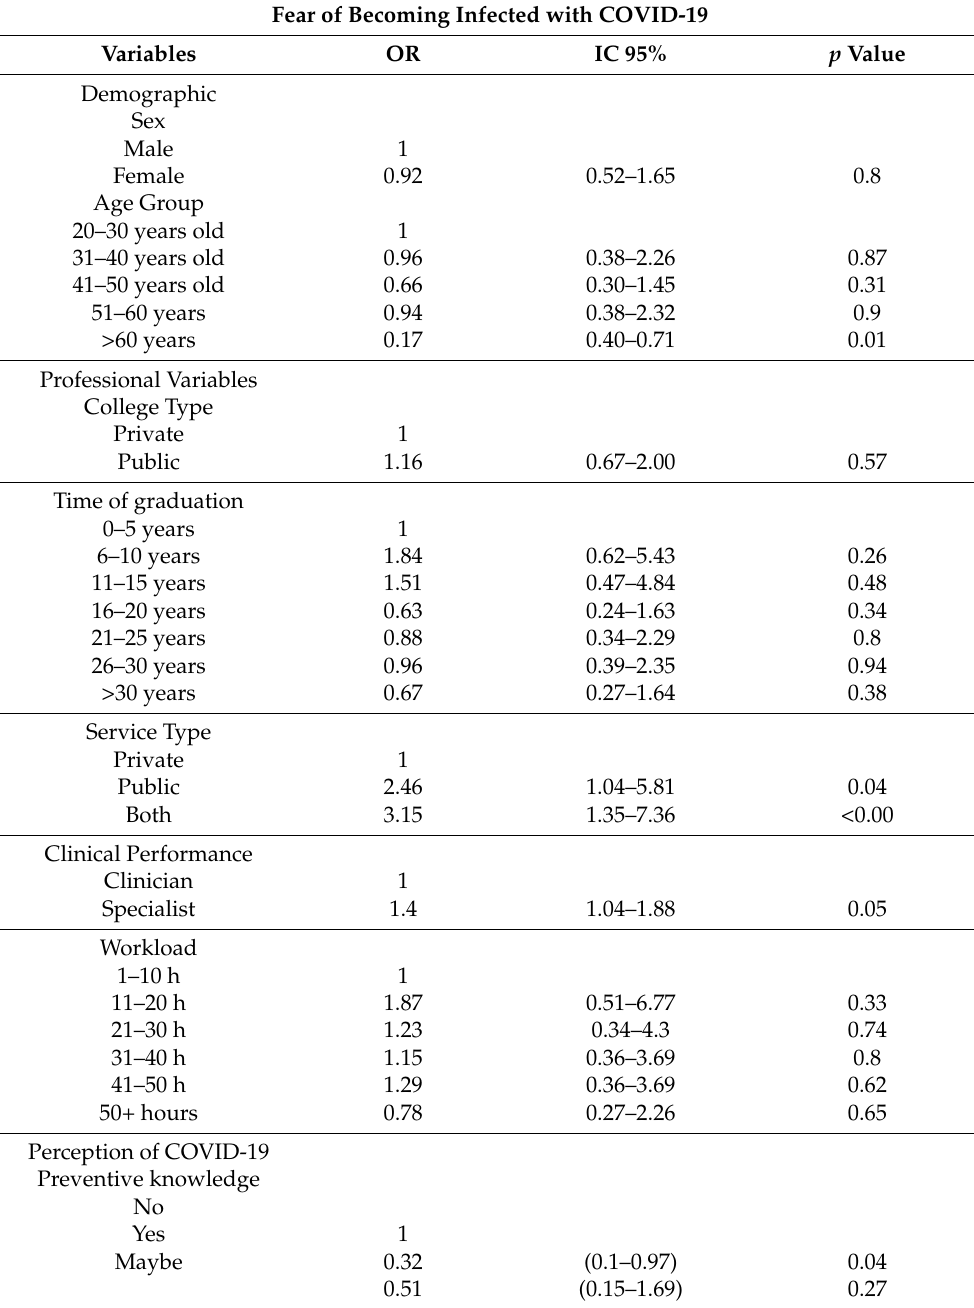
Table 3. Unadjusted logistic regression among factors associated with fear of becoming infected by COVID-19. Fear of Becoming Infected with